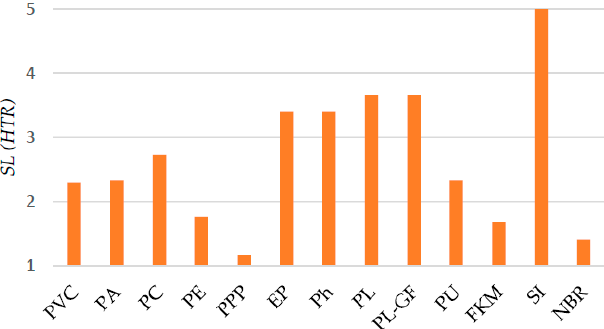
Figure 4. High temperature resistance in terms of stringency level